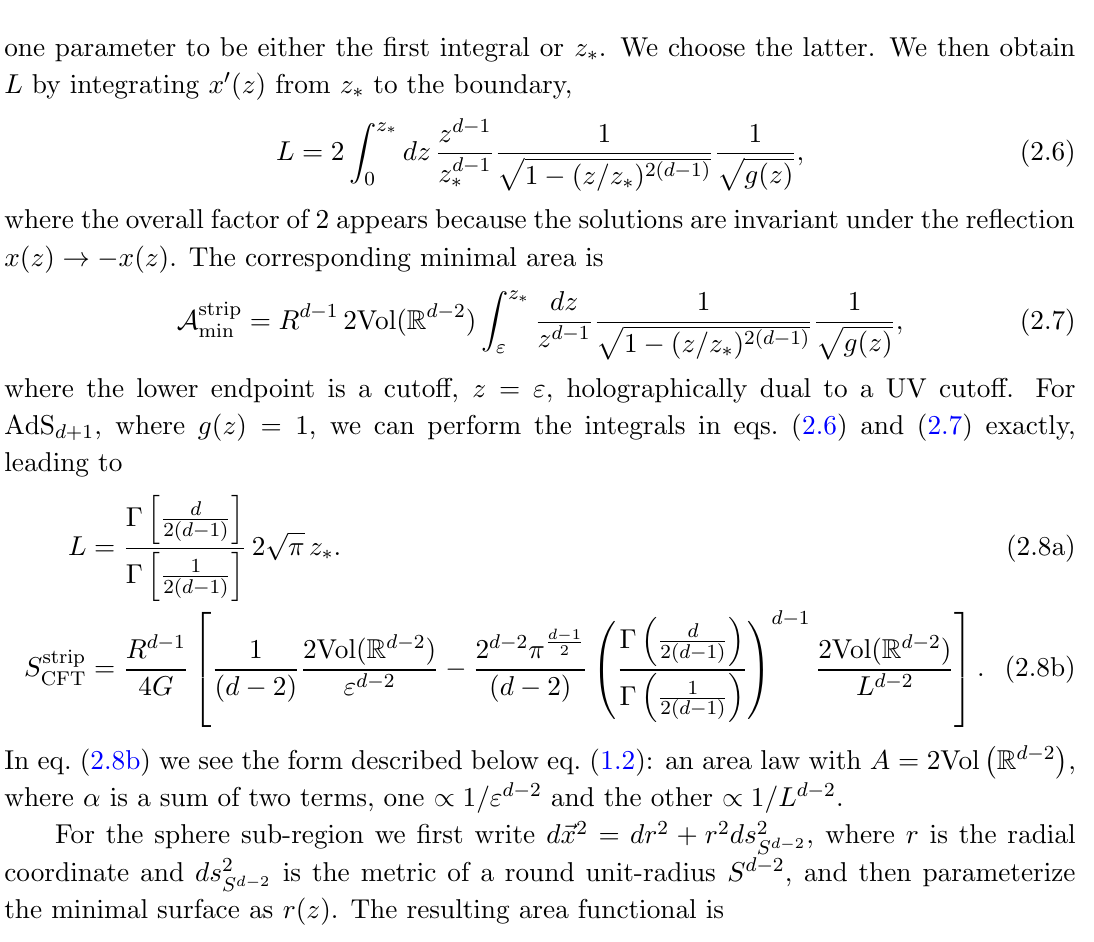
Figure 2. (a) Schematic depiction of the minimal surface for a strip sub-region of width L . The asymptotically AdS d +1 boundary is at z ! 0. The minimal surface, depicted by the dashed lines, \hangs down" from the strip at the boundary to a maximal z value, z depiction of the minimal surface for a sphere sub-region of radius L